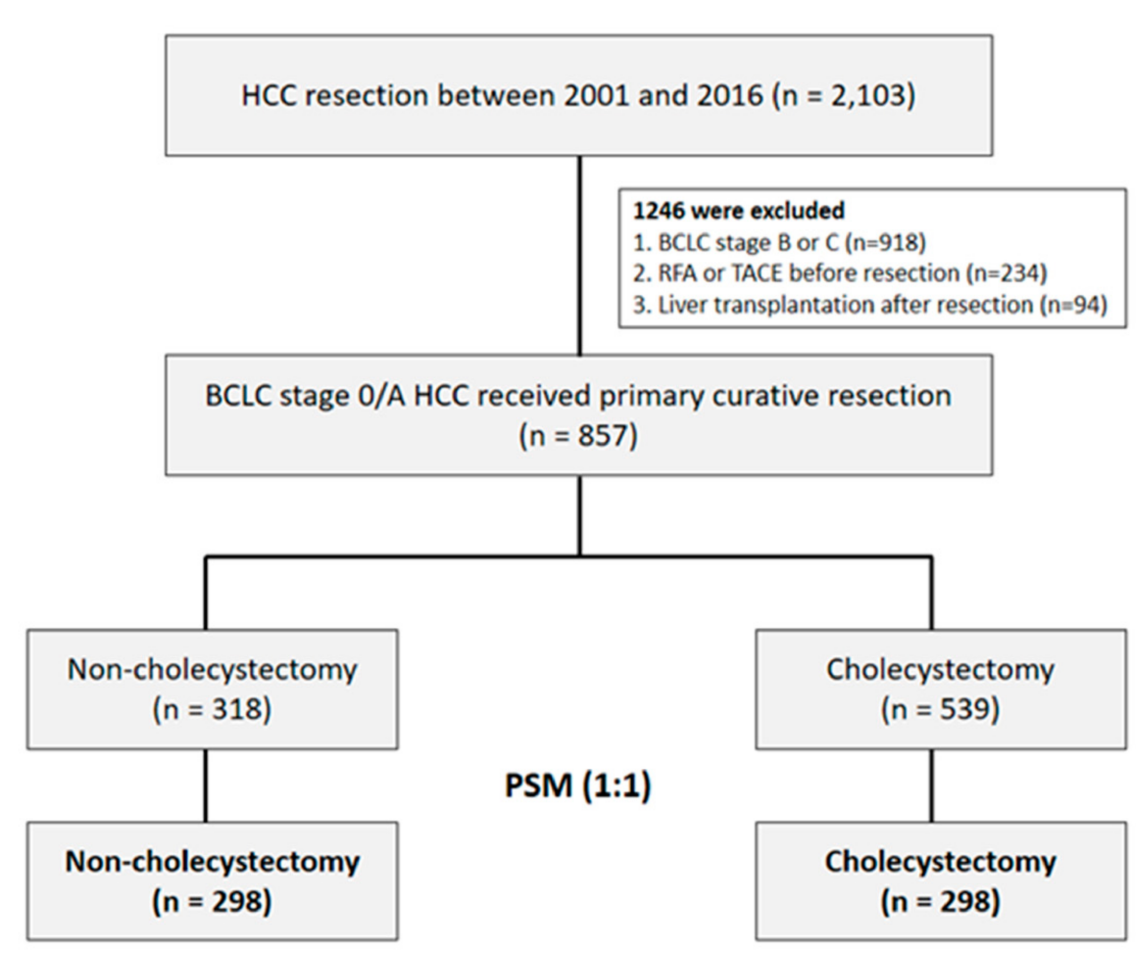
Figure 1. Patient selection flow